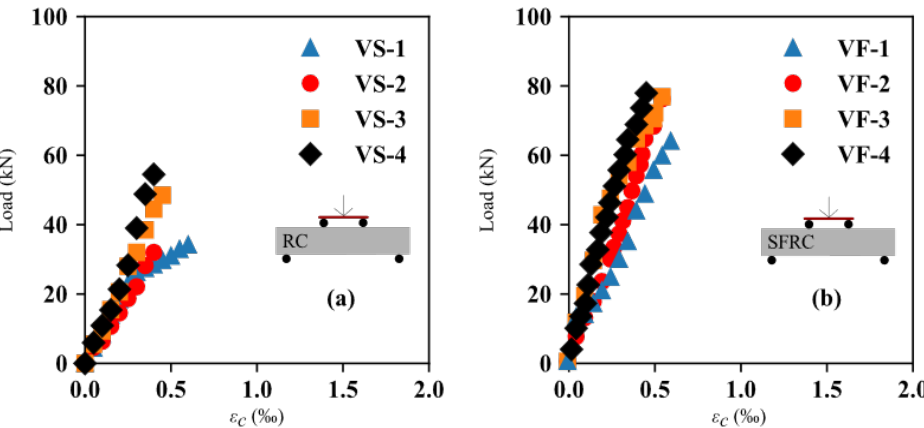
Figure 9. Concrete strains for RC and SFRC series.